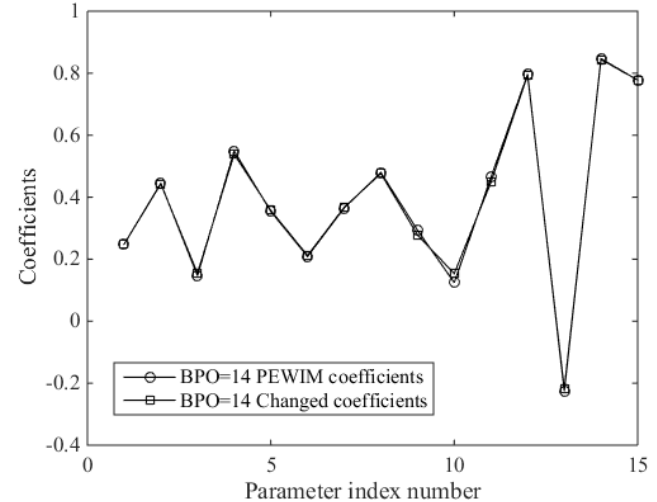
Figure 13. Comparison of parameterization matrix using the PEWI method.